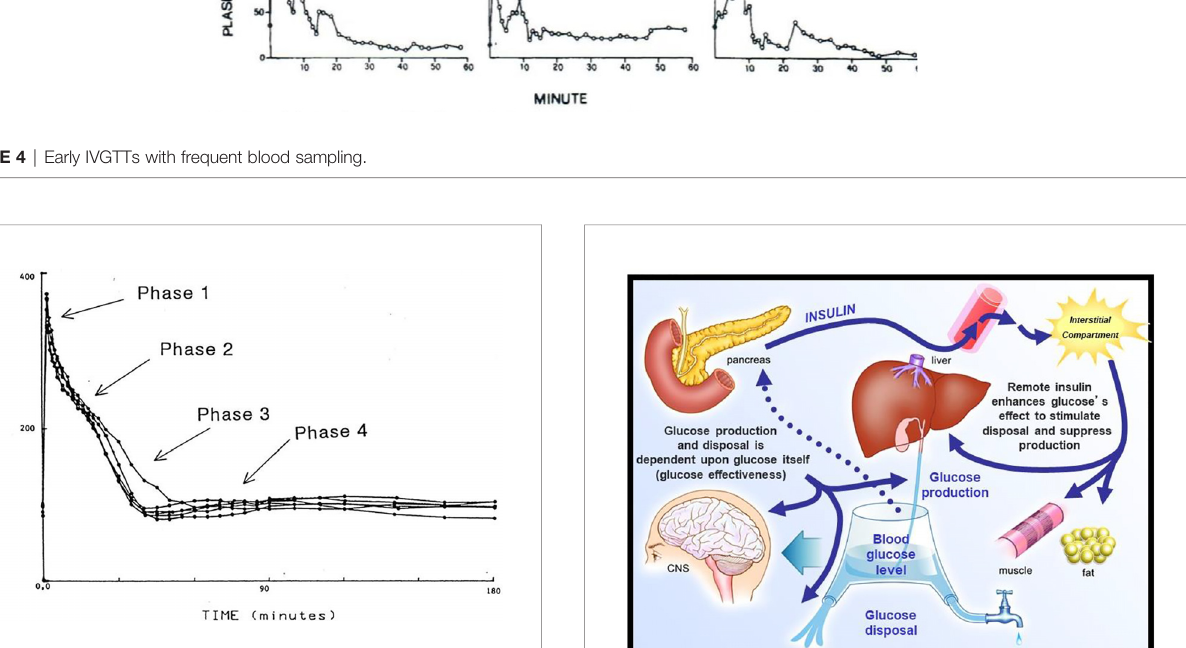
FIGURE 5 | IVGTT phases.